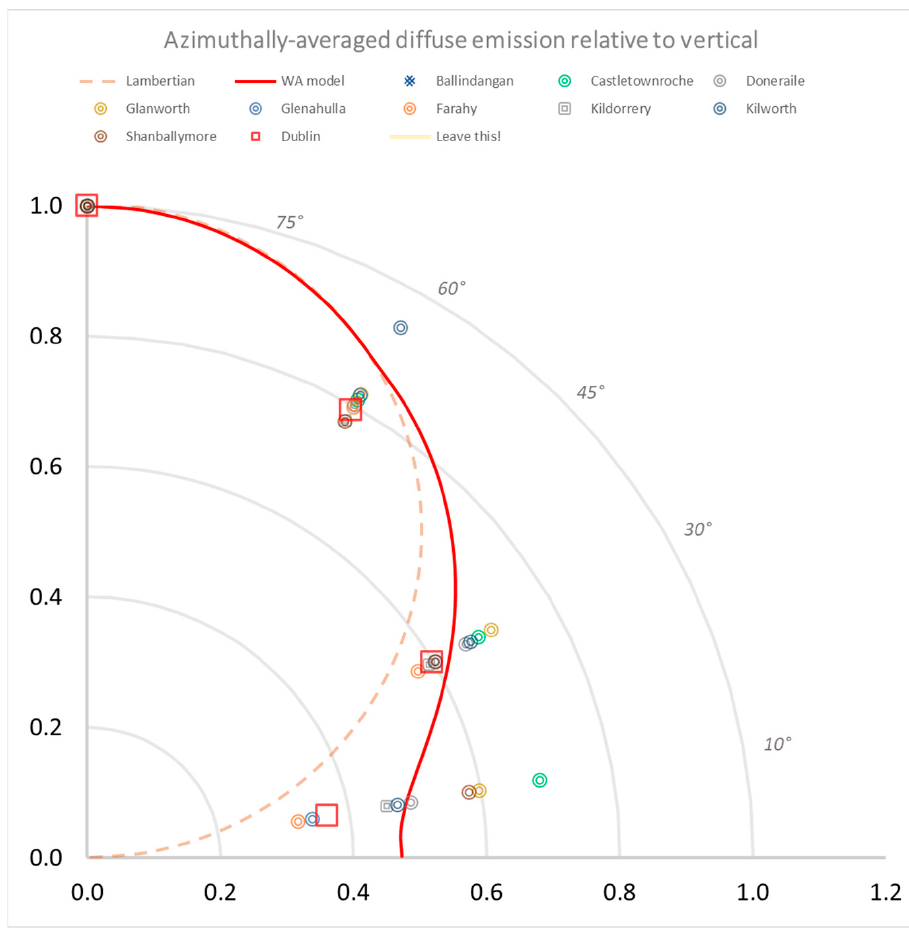
Figure 8. Azimuthally averaged diffuse emission data for the Irish towns normalised to the zenithal diffuse emission in each case. As before, the dashed line indicates simple Lambertian emission and the distribution used in the New World Atlas is indicated by the solid line.